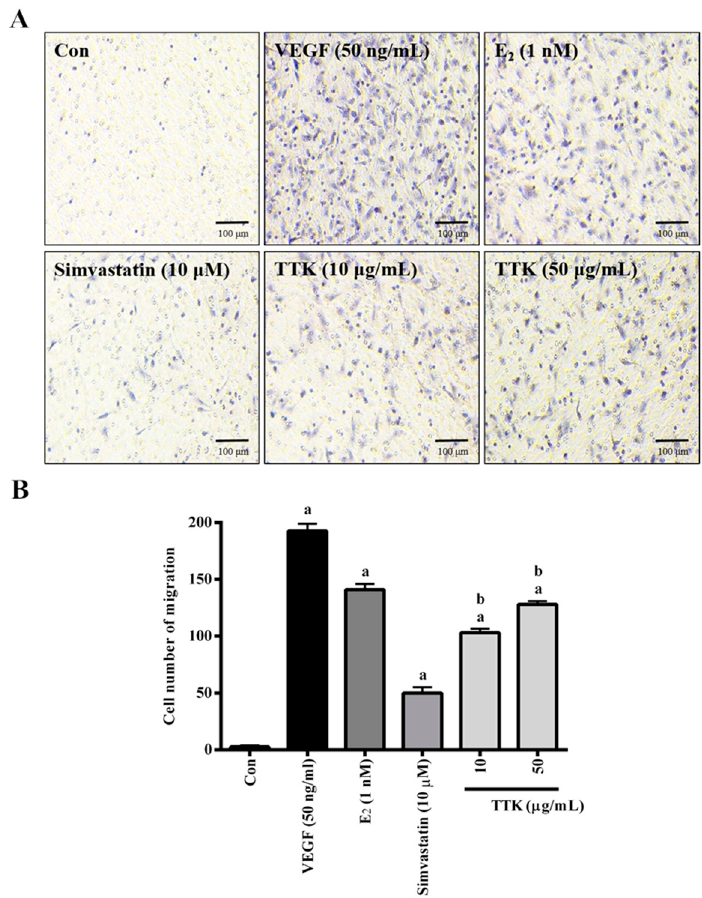
Figure 2. Effect of TTK on migration of HUVECs. ( A ) The cells were treated with TTK (10, 50 μ g/mL), 50 ng/mL VEGF, or 1 nM 17 β -estradiol, or 10 μ M Simvastatin. Cell migration was evaluated by observing each section under a microscope using the tran-swell chamber. (magnification, 200×). ( B ) The migrated cells were numbered in at least three fields after each examination, and the data are expressed in the number of cells per field. Data present means ± SEM. of three experiments. a p < 0.001 vs. control (untreated cells), b p < 0.001 vs. Simvastatin.